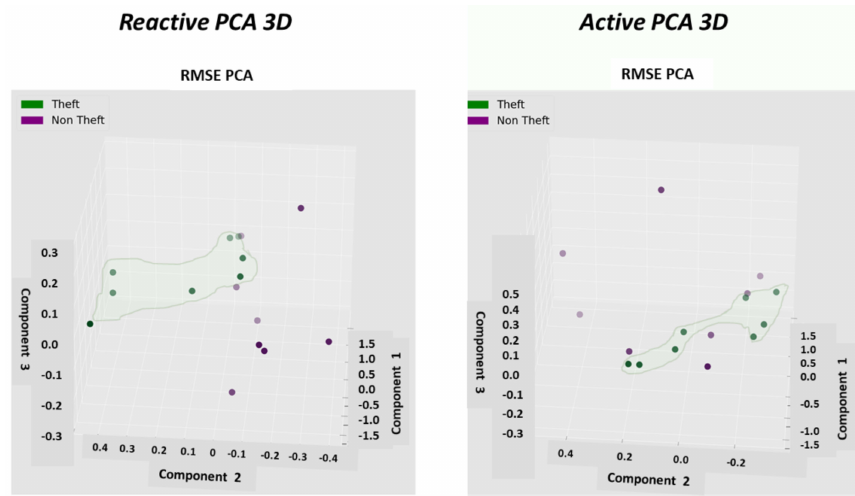
Figure 14. Reactive vs. active 3D PCA of daily-hourly trends RMSE. First filtration: fraud— technical/nontechnical. Non-fraud—other anomalies. Here, fraud is actual fraud. Technical loss type differentiation is similar. The soft green surface is meant to intensify theft cluster.